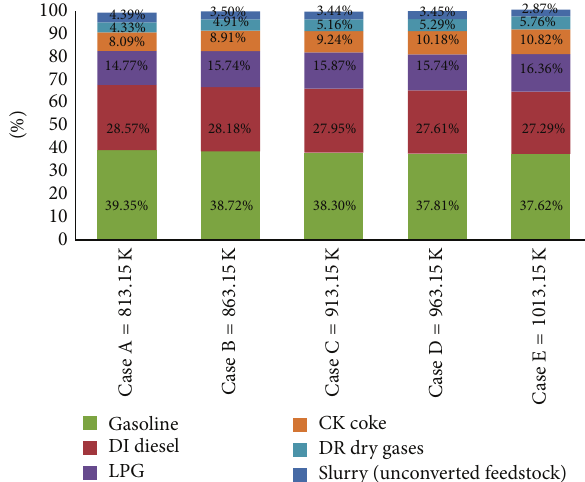
Figure 16: Catalyst volume fraction profiles for catalyst-to-oil